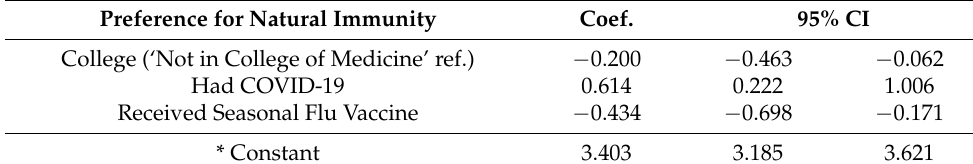
Table 6. Linear regression model regarding the Preference for Natural Immunity. Preference for Natural Immunity